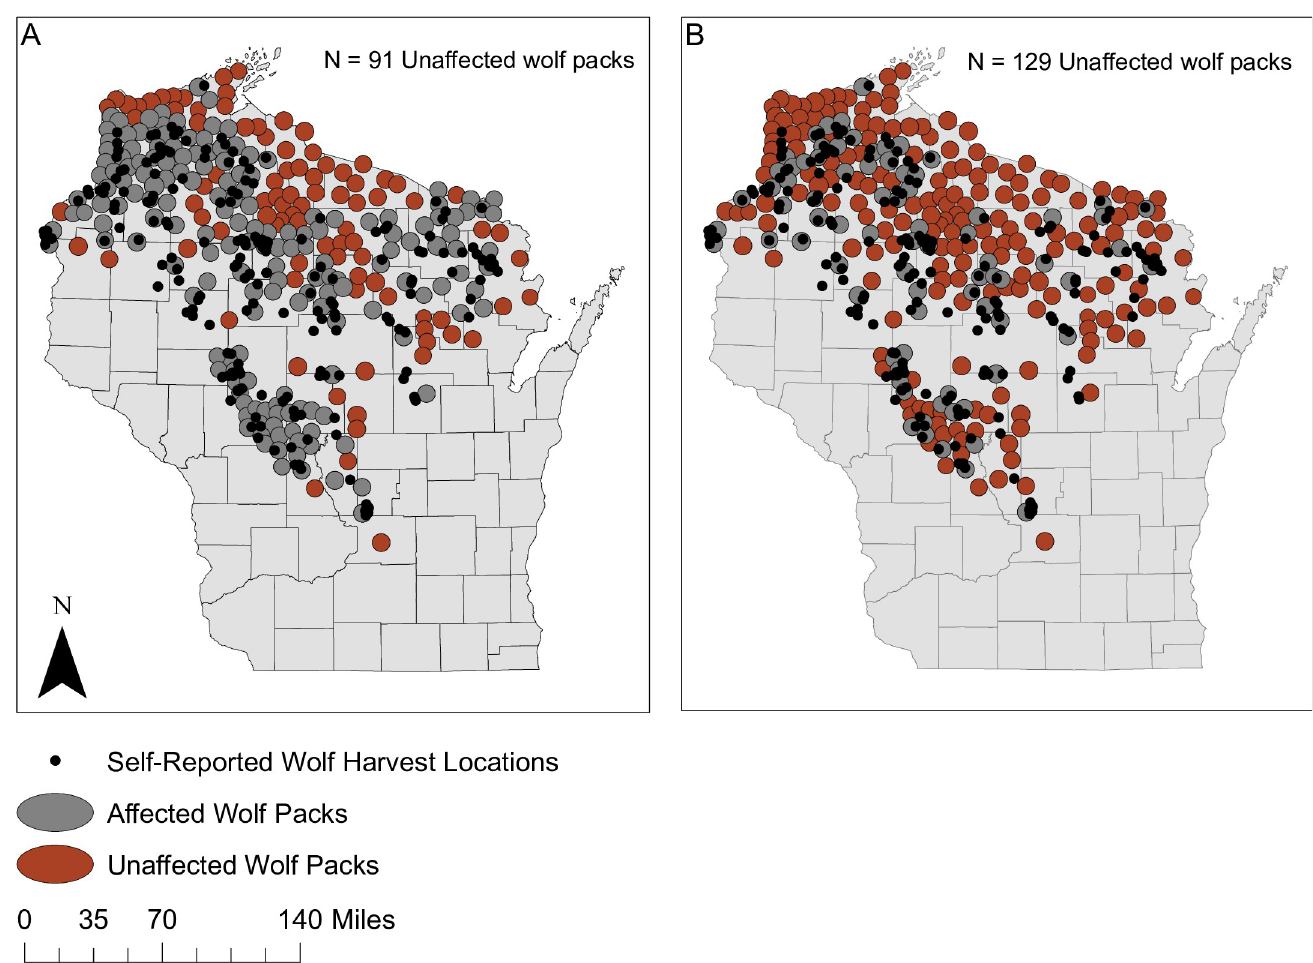
Fig 1. Two scenarios for Wisconsin wolf packs affected by wolf-hunt. (A) 91 breeding packs scenario: Any wolf kill location self-reported by hunters was extended by the average wolf territory size (161.3 km 2 according to [28]) and if it overlapped a wolf territory, those wolf packs were assumed not to have reproduced successfully. (B) 129 breeding packs scenario: Any hunter-reported wolf-kill location inside a wolf pack territory was assumed to have prevented that pack from reproducing successfully. To estimate the number of breeding wolf packs for these two scenarios, we used ArcGIS Desktop 10.7.1 to convert the map of 2020 Wisconsin wolf pack locations reported in [22] and the February 2021 self-reported wolf harvest location map from [27] into shapefiles. We then used spatial overlay and geo-rectification to find overlap in territories and self-reported kill locations. The Wisconsin county map was sourced from the WDNR Open Data Portal (https://data-wi-dnr.opendata.arcgis.com/).